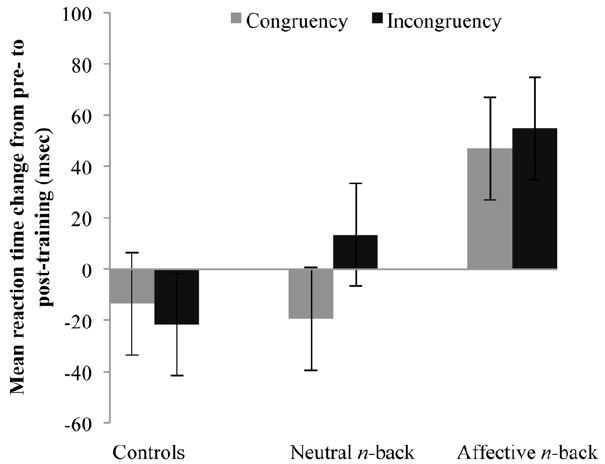
Figure 4. Training benefits on the emotional Stroop only in affective training group. Changes in reaction time (post-training reaction time in msec – pre-training reaction time in msec) in congruent and incongruent indices on the emotional Stroop task from pre-training to post-training, displayed such that the higher the change the greater the training-related